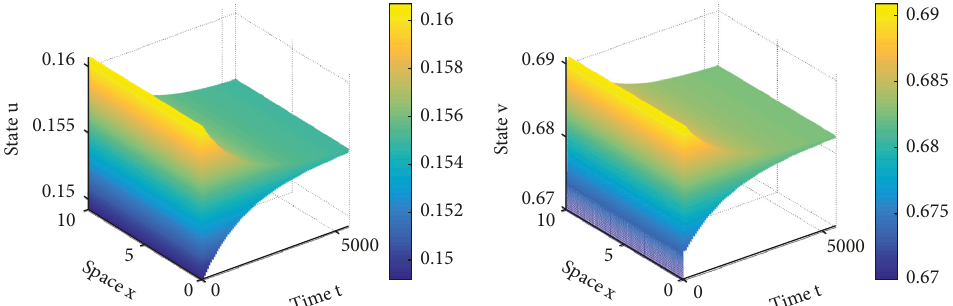
Figure 10: The evolution process of node u ( t ) and v ( t ) in system (9) when D